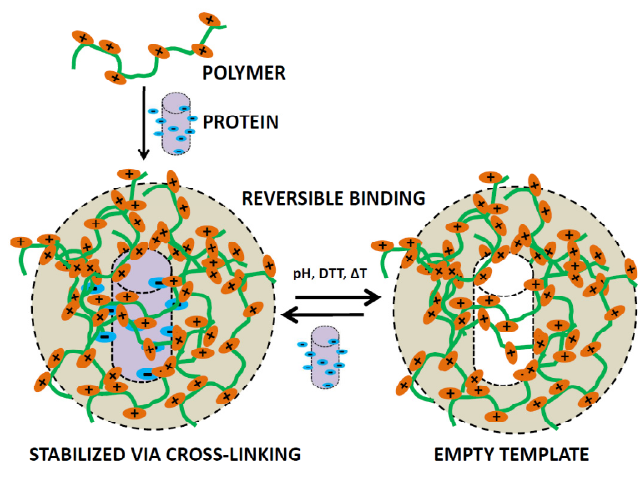
Figure 6. Schematic representation of a polymer structure, which is able to reversibly bind protein structures using the protein-imprinted